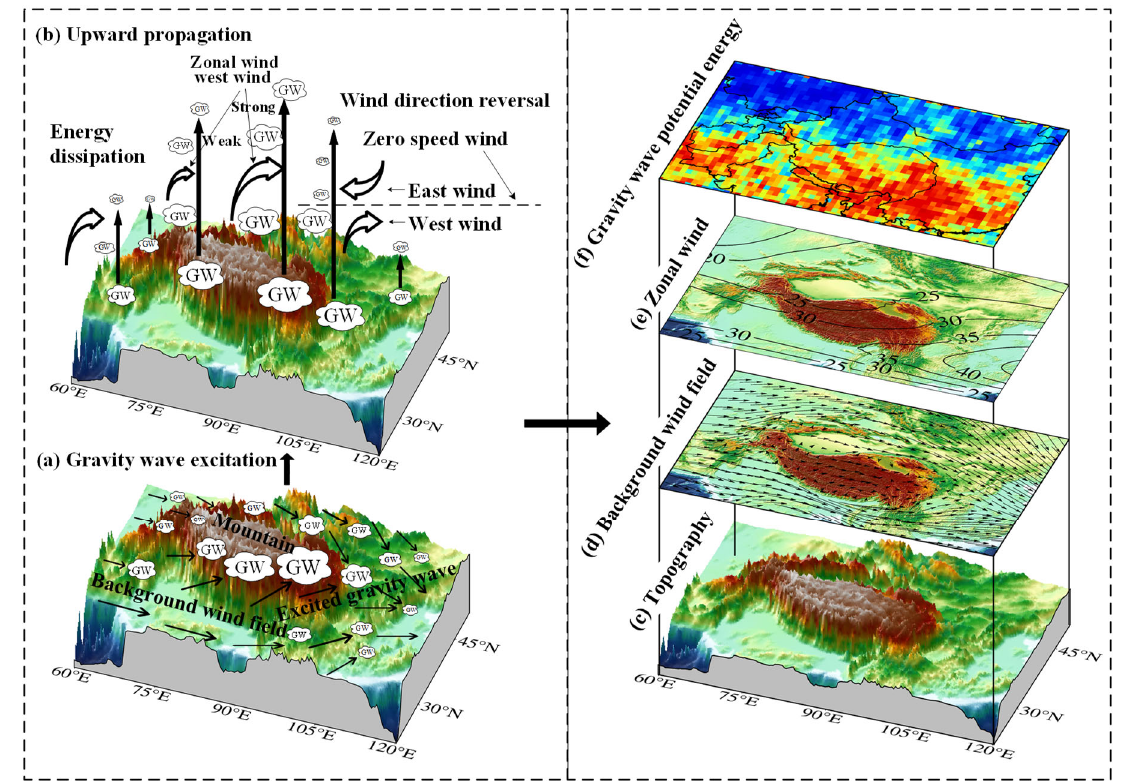
Figure 14. The general process of ( a ) the GW (topographic waves) excitation and ( b ) the upward propagation around TP, and the corresponding observations of ( c ) the topography, ( d ) the background wind at the altitude of 3 km, ( e ) the average zonal wind of 8~18 km, and ( f ) the GW Ep in the lower stratosphere (18~20 km).